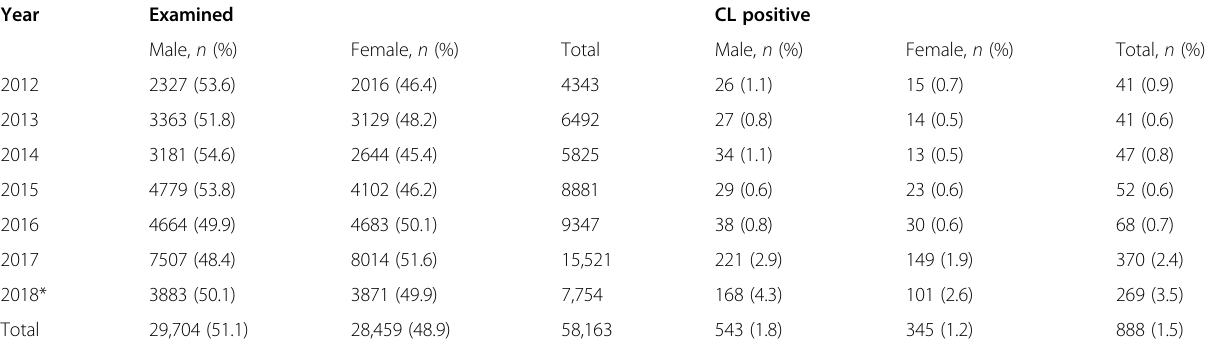
Table 1 Prevalence of CL among patients who visited the BMH Dermatology Department from 2012 to